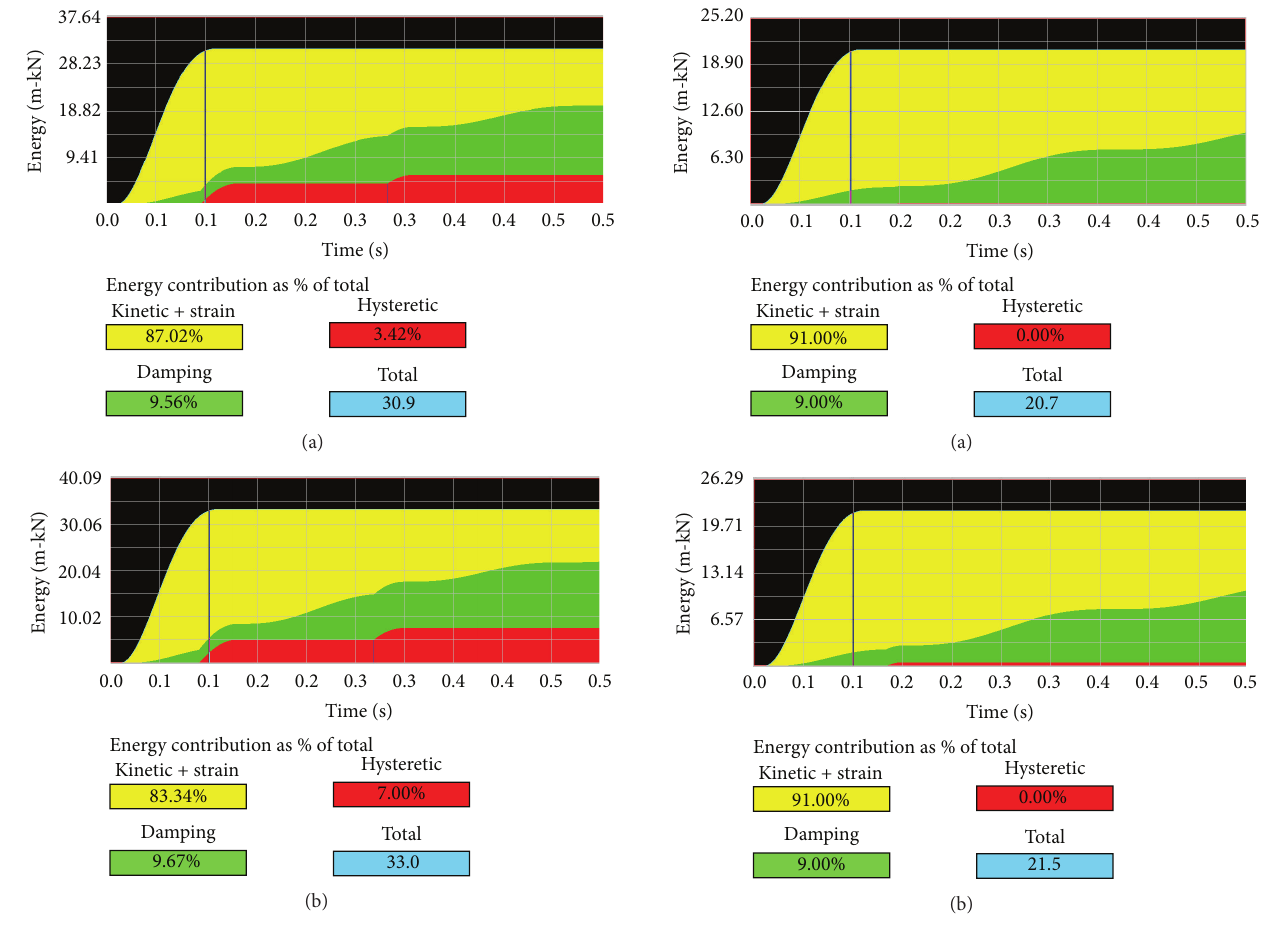
Figure 9: Blast load with a 24 m of explosion distance: (a) uncor- roded shear wall and (b) corroded shear